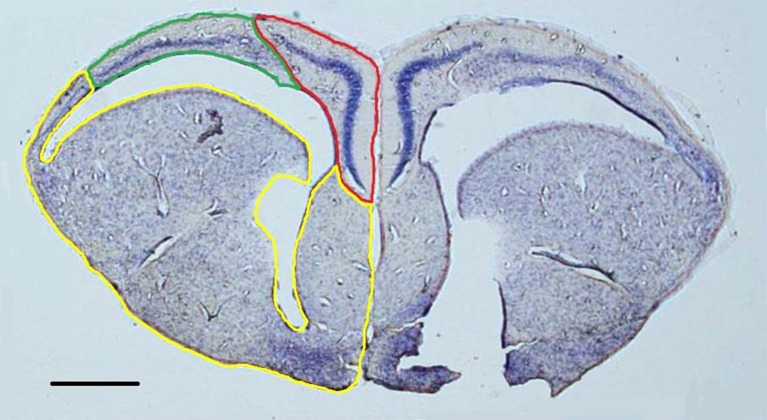
Representative nissl-stained section (1.25x) with the medial cortex (red), dorsal cortex (green), and remainder of the telencephalon (yellow) outlined in the left hemisphere. Both hemispheres were contoured in order to construct volumetric estimations. Scale bar = 500 μm.